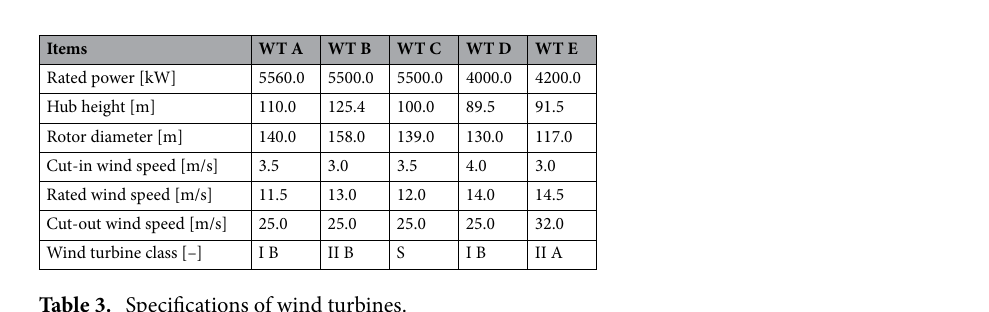
Table 3. Specifications of wind